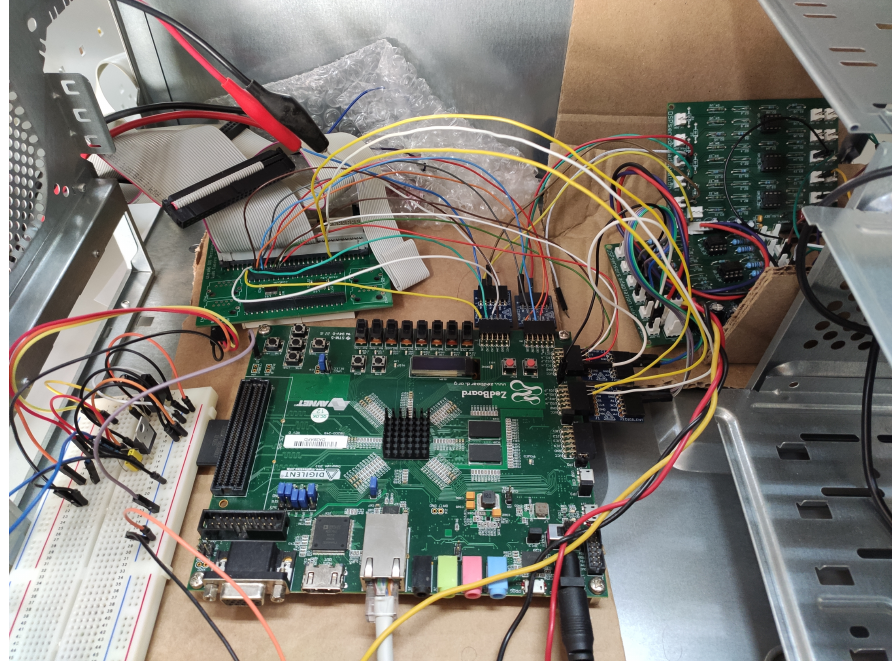
Figure 27. Zedboard wiring for initial testing of power inverter